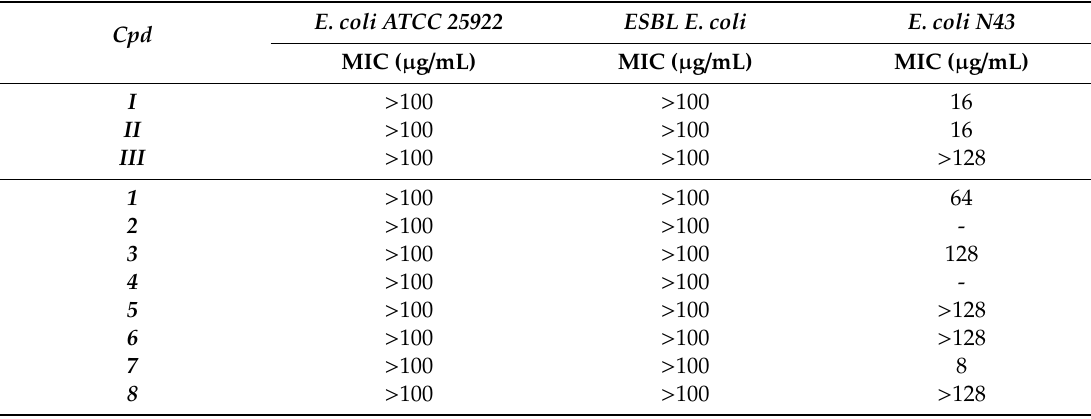
Table 4. Inhibitory activity of compounds I–III and 1–8 against di ff erent E. coli